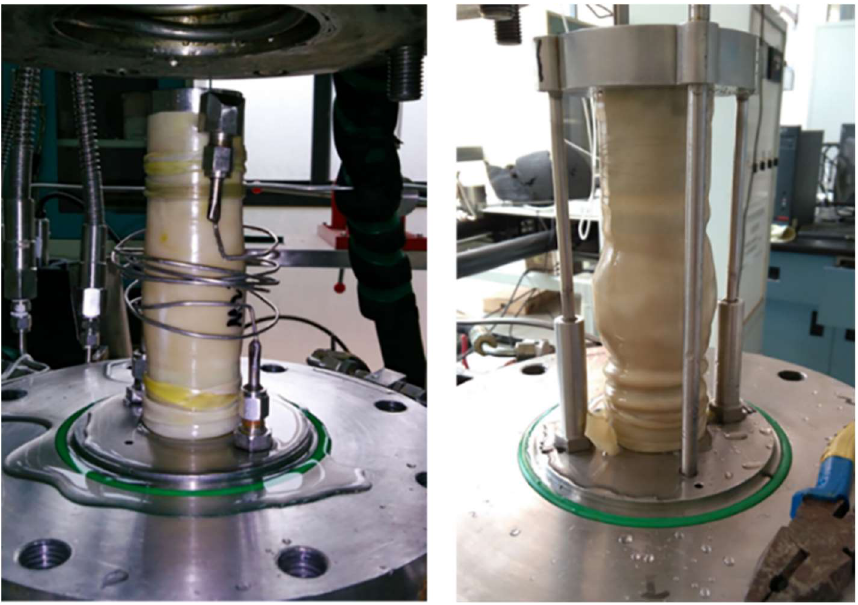
Figure 5. State of the sample before and after triaxial test.